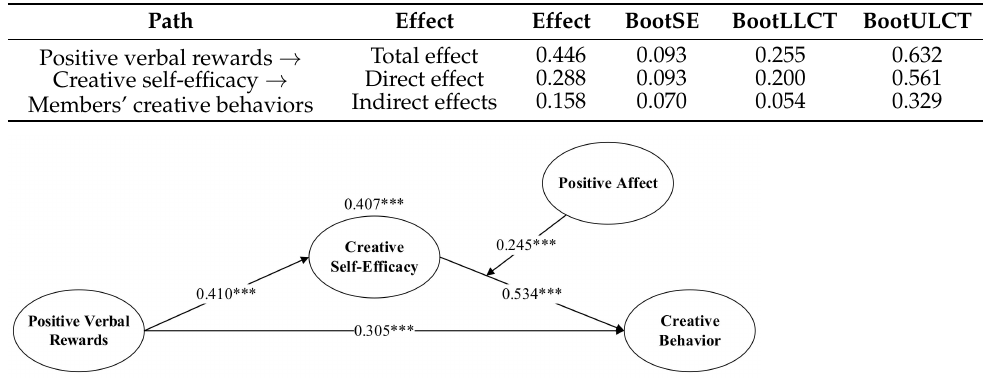
Figure 2. Model validation result, *** indicates p < 0.001.